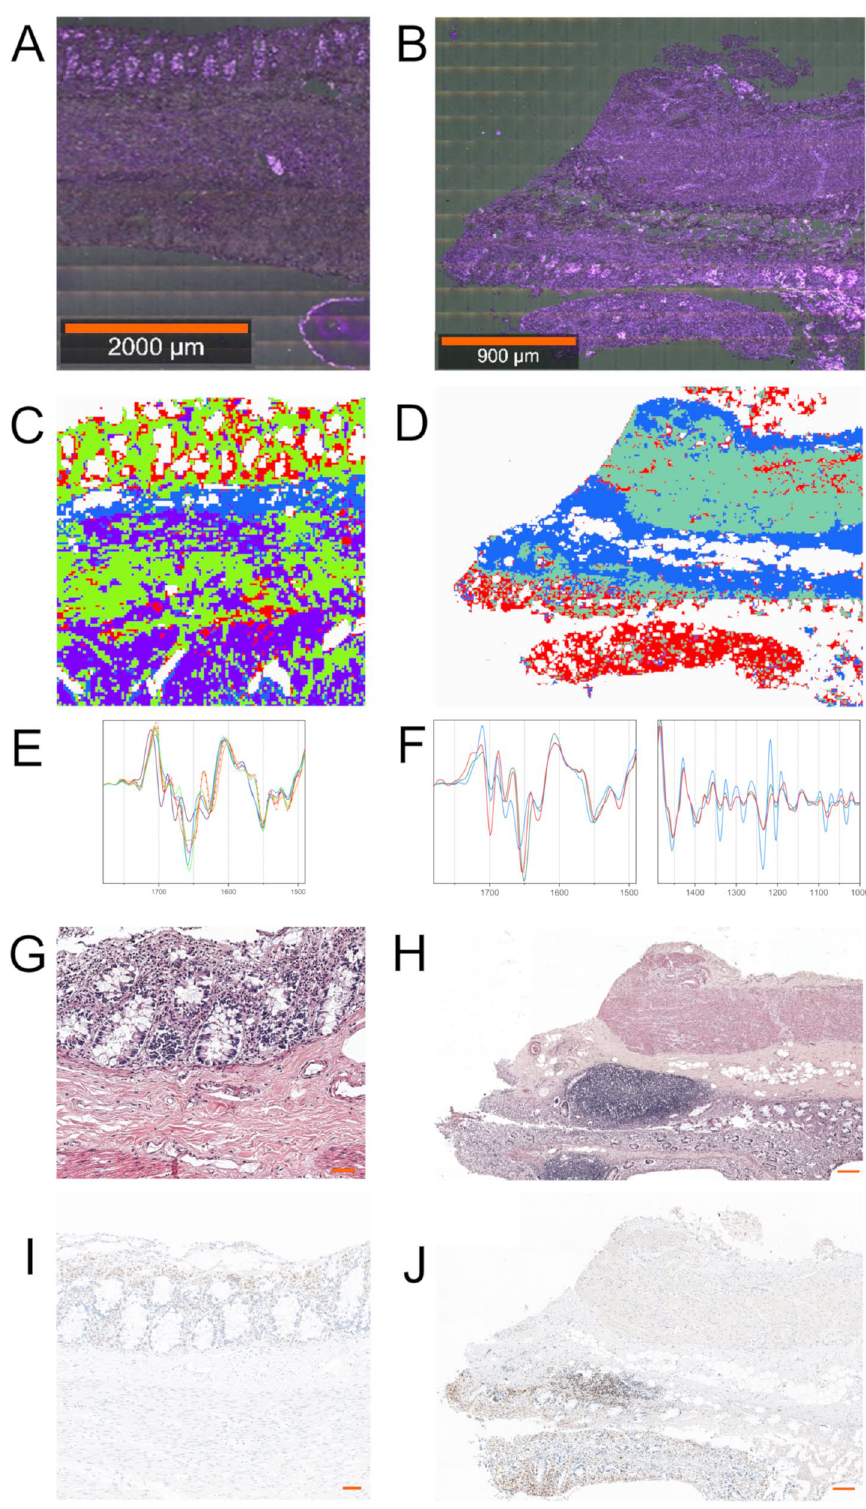
Figure 5. ( A ) A white-light image of post-mortem FFPE intestinal cross-sections of the sigmoid colon showing two regions of interest (ROIs) with a lower distribution of immune cells (1400 µm × 1400 µm) selected for FTIR imaging (20 × magnification); ( C ) The corresponding UHCA false-color cluster map (middle) and mean second derivative IR spectra; a red dashed trace from ROI ( E ); blue—submucosa and serosa, red—immune cells and lymphoid tissue, violet—smooth muscles, light green—lamina propria and connective tissue (down). ( B ) A white-light image of a post-mortem FFPE intestinal cross-section of the ascending colon showing ROI (2100 µm × 2800 µm) with the gut-associated lymphoid tissue (GALT) selected for FTIR imaging (upper, 20 × magnification); ( D ) UHCA false-color cluster map (middle) and their mean second derivative IR spectra ( F ). The colors of spectra correspond to the colors of classes in UHCA maps. Representative histological slides of H & E staining ( G , H ) and immunohistochemistry against CD3 + cells; scale bars = 50 μm ( G , I ) and 200 μm ( H , J